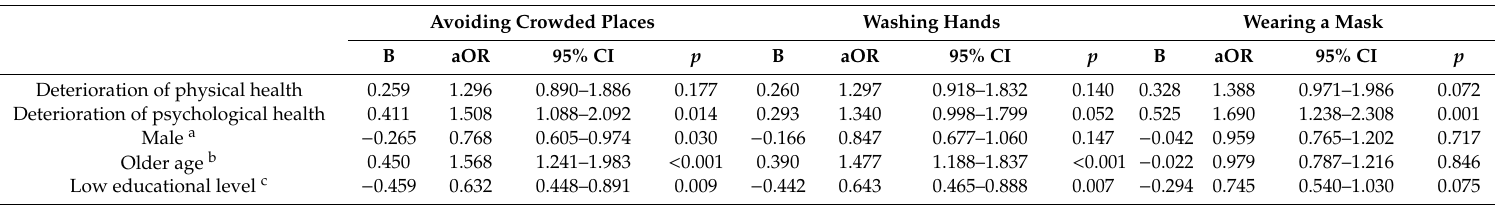
Table 4. Association between the deterioration of physical and psychological health and adoption of protective behaviors against COVID-19. Avoiding Crowded Places Washing Hands Wearing a Mask B aOR 95% CI p p Deterioration of physical health